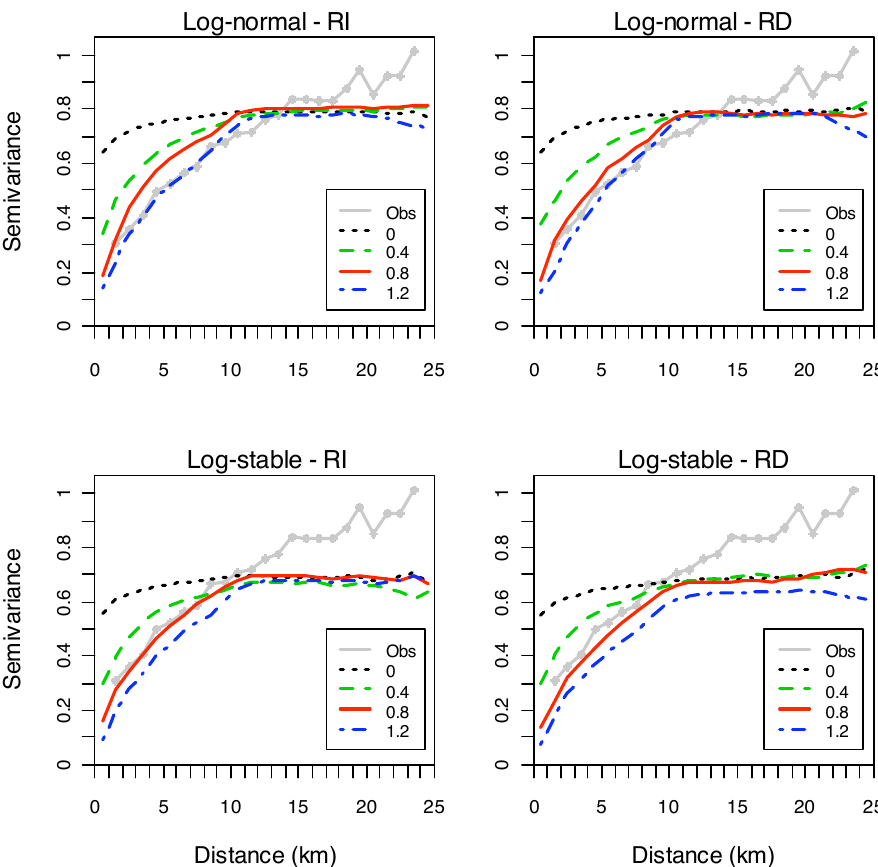
Fig. 6. Semivariogram of log-transformed rainfall rates R > 0 . 001mm (15-min) − 1 from rain gauges (gray heavy line and solid circles) and from simulations (colored lines) using log-normal and log-stable distributions, rainfall independent (RI) σ , rainfall dependent (RD) σ , scale independent σ ( γ =0) and scale dependent σ ( γ =0.4, 0.8, and